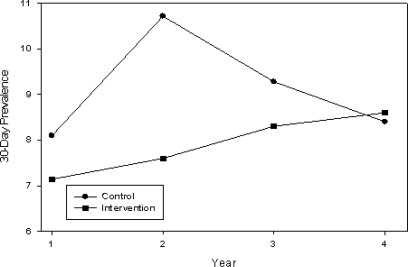
30-day chewing tobacco prevalence.